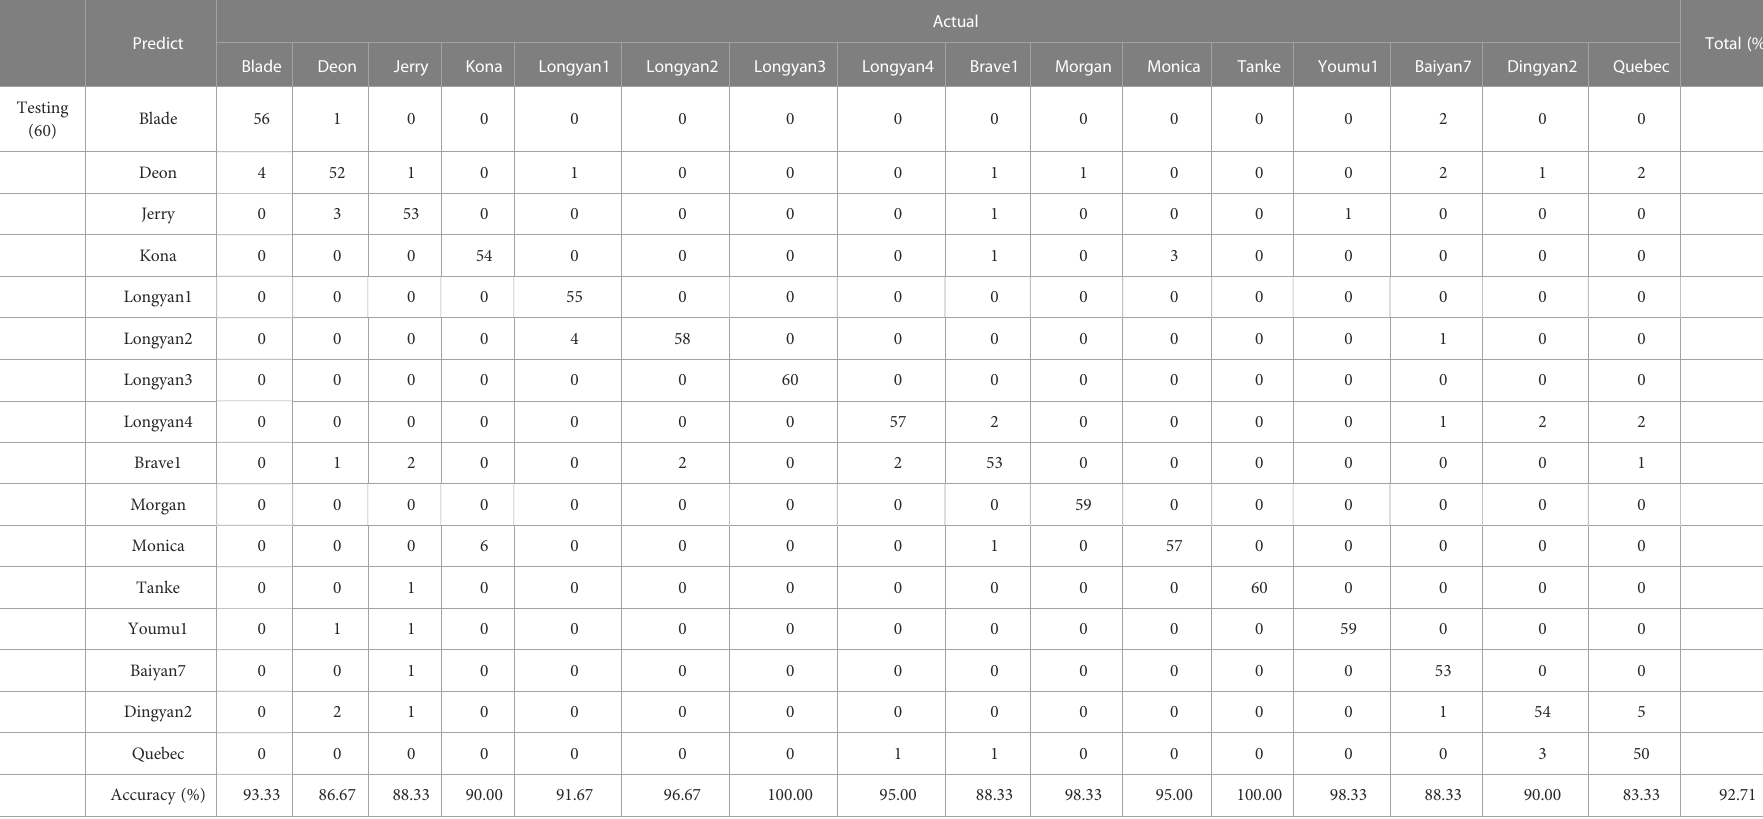
TABLE 2 Discrimination performance based on SVM with morphology and spectral features of 16 Avena sativa L. cultivars.